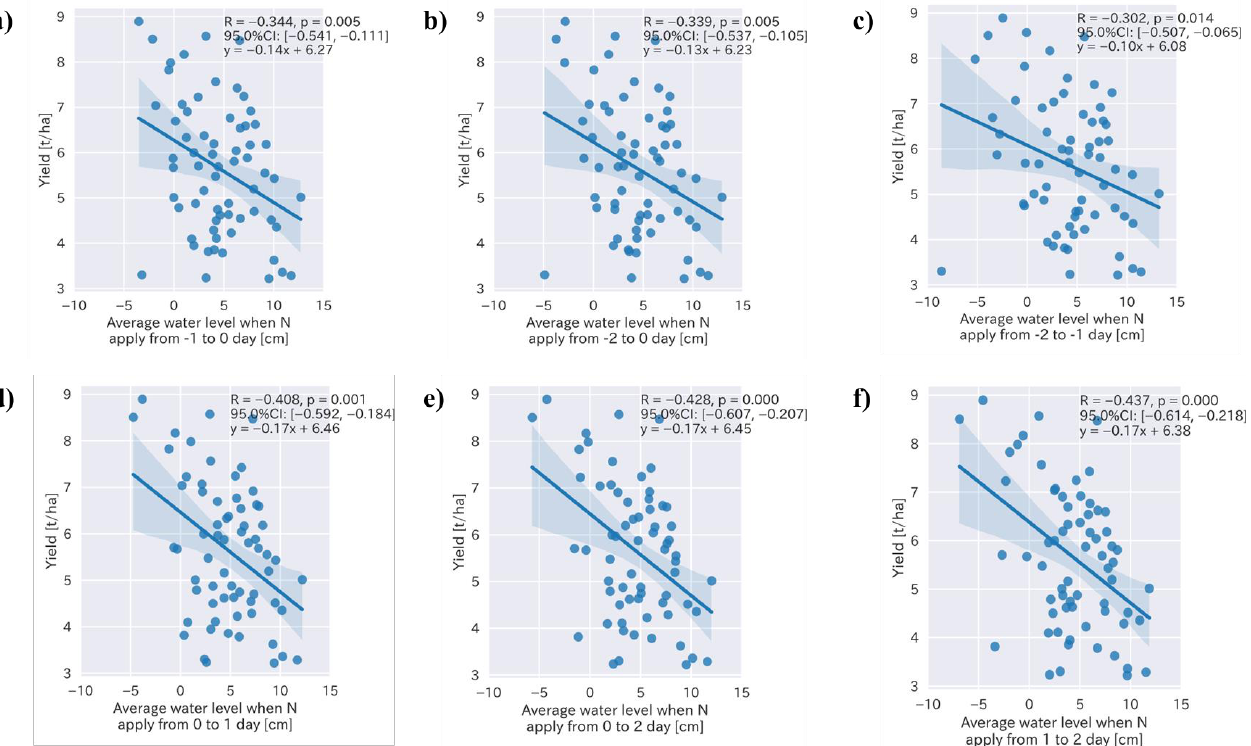
Figure 4. Relationships between the rice yield and average water level two days before and after nitrogen fertilizer application.